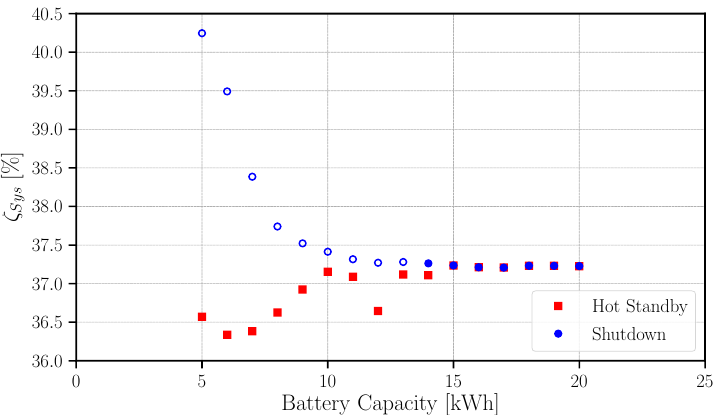
Figure 23. Degree of efficiency of the system at an electricity consumption of 15 kWh/d for different battery capacities for the shutdown and the hot standby mode (unfilled points for shutdown indicate unfeasible